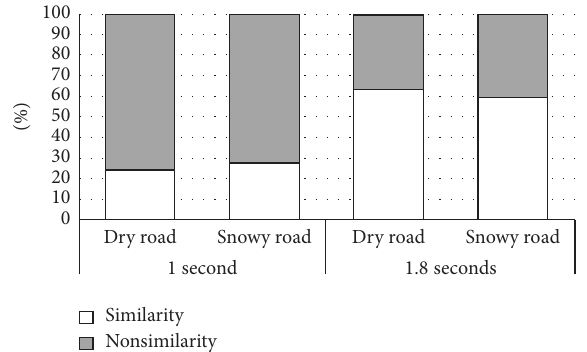
Figure 1: Drivers’ reported reaction similarity compared with the Adaptive Cruise